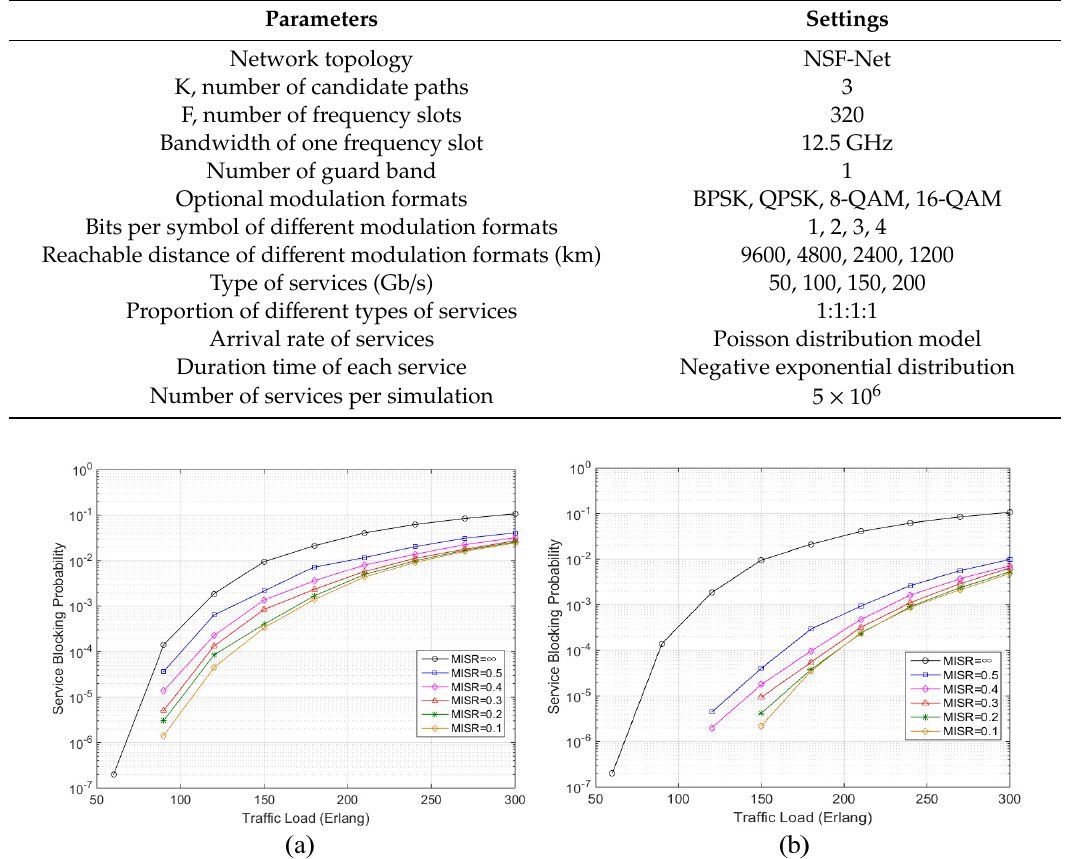
Figure 3. Simulation results of the service blocking probability. ( a ) Simulation results on the service blocking probability vs. traffic load with different values of maximum invalid spectrum ratio (MISR) when no spectrum defragmentation is adopted, ( b ) simulation results on the service blocking probability vs. traffic load with different values of MISR when spectrum defragmentation is adopted.